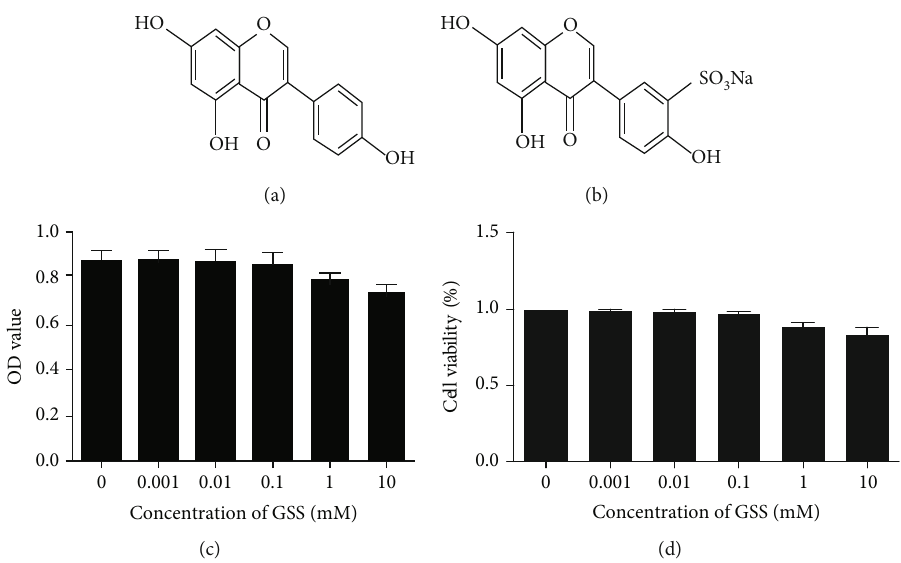
Figure 3: Chemical structure of GSS and its e ff ect on EC viability. (a) The chemical structure of genistein. (b) The chemical structure of genistein-3 ′ -sodium sulfonate. To observe the e ff ect of GSS on the viability of ECs, cells were stimulated with 0, 0.001, 0.01, 0.1, 1, and 10mM GSS for 24h, respectively. The OD value (c) and EC viability (d) were measured by CCK-8